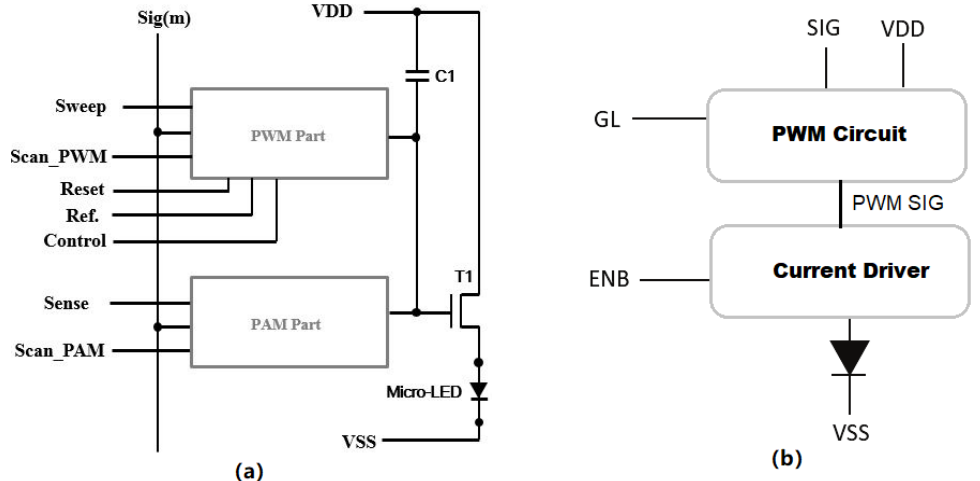
Figure 10. ( a ) PWM pixel circuit [52] (Reprinted with permission from ref. [52]. Copyright 2022 John Wiley and Sons). ( b ) Schematic diagram of current + PWM pixel circuit.